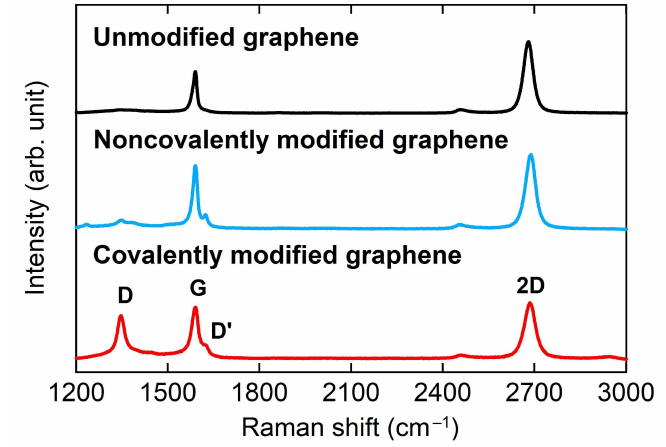
( a ) CVs during covalent modification of CVD-grown graphene using 1 mM 4-Nitrobenzenediazonium tetrafluoroborate in 0.1 M HClO 4 at scan rate of 50 mV / s. ( b ) The schematic diagram of electrochemical covalent modification to the graphene surface.